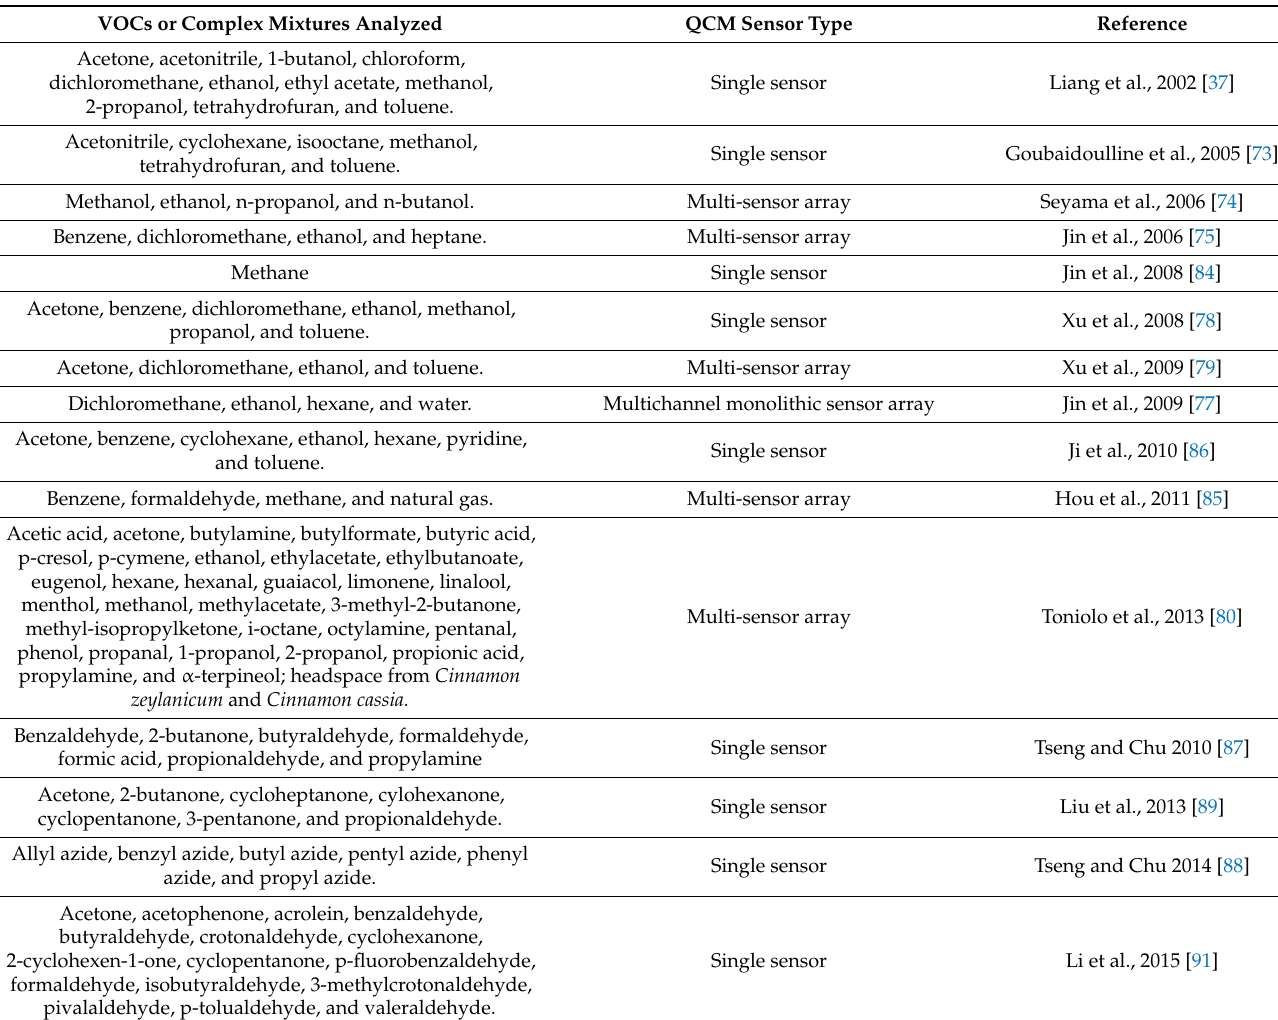
Table A1. Summary of analytes detected by IL-based QCM